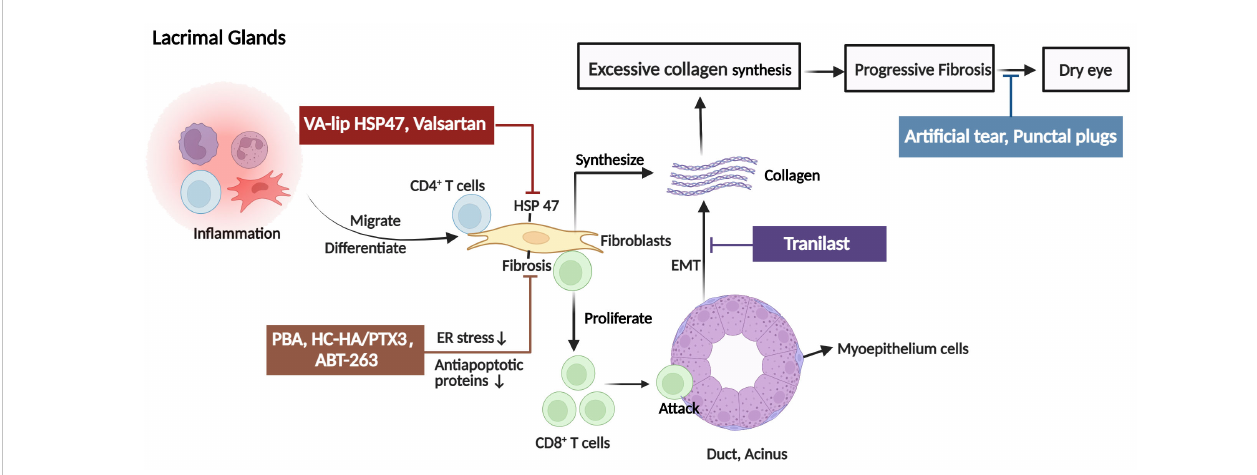
FIGURE 2 The pathogenic mechanism in the lacrimal glands (LG) of ocular GVHD and treatment. Donor CD4+ T cells and activated CD8+ T cells in fi ltrate the periductal area of the lacrimal gland causing tissue injury. In addition, fi broblasts with high expression of heat shock protein (HSP)47 are also activated and synthesize excessive collagen contributing to fi brosis in the LG and causing dry eye. The clinical therapies for ocular GVHD patients with dry eyes include arti fi cial tears and punctal plugs. For novel therapeutic targets, it is reported that tranilast alleviates in fl ammation and retard fi brotic changes in LG pathology in cGVHD by preventing epithelial-mesenchymal transition. VA-lip HSP47 and Valsartan mainly reduce collagen synthesis by inhibiting or decreasing the expression of HSP47 fi broblasts. The mechanisms by which PAB, HC-HA/PTX3, and ABT-263 reduced fi brosis may involve fi broblasts. PAB speci fi cally reduced endoplasmic reticulum stress induced by cGVHD in fi broblasts to alleviate fi brosis. HC-HA/PTX3 decreased the in fi ltration of fi broblasts to inhibit abnormal collagen synthesis. As for ABT-263, it selectively inhibited the antiapoptotic proteins (BCL-2 and BCL-xL), thereby mitigating the detrimental effects of senescent cells, including fi broblasts, on ocular GVHD. EMT, epithelial-mesenchymal transition; PBA, 4-phenyl butyric acid; HC-HA/PTX3, heavy chain-hyaluronan/pentraxin 3; ER, endoplasmic reticulum, VA-lip HSP4, vitamin A – coupled liposomes containing HSP47 small interfering RNA (siRNA) against HSP47. (Created with